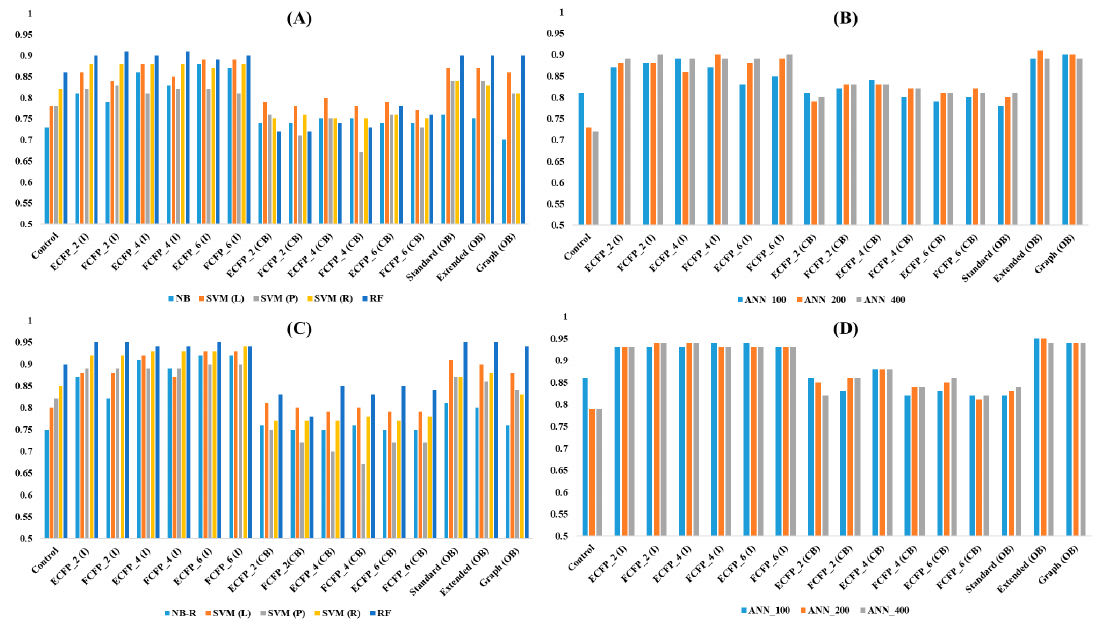
Figure 3. Models built using integer and binary type fingerprints for hERG blockers. X-axis denotes fingerprint types whereas Y-axis denotes the performance. Control lacking fingerprint only include